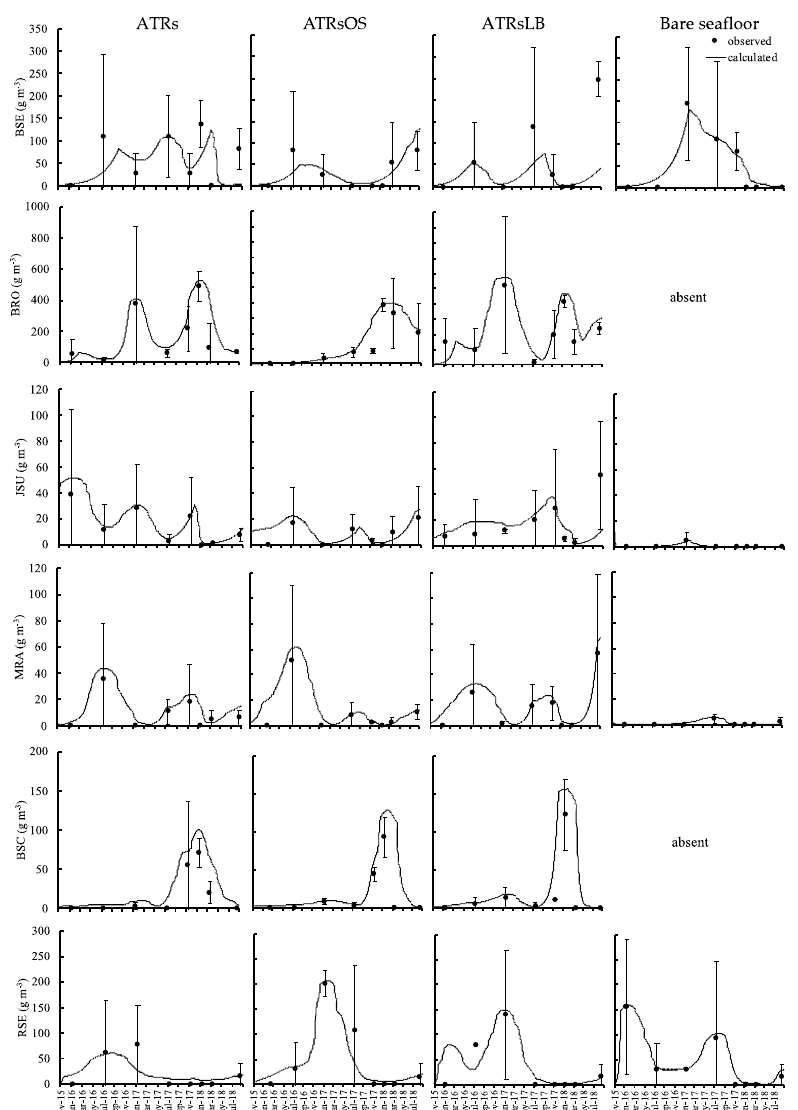
Figure 5. Numerical model simulation outputs (connected curves) and observed values (average: filled dot; bar: deviation) for fish biomass at the different types of ATRs and bare seafloor in Mitsu Bay, Japan.